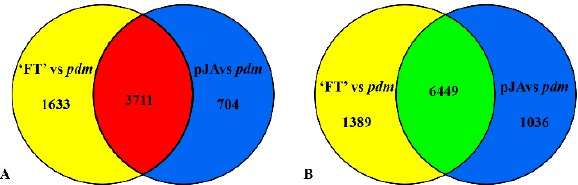
Figure 4. Numbers of differentially expressed genes (DEGs) identified in ‘FT’ vs. pdm and pJA vs. pdm comparisons. ( A ) Mutually up-regulated DEGs (red) and ( B ) mutually down-regulated DEGs (green).